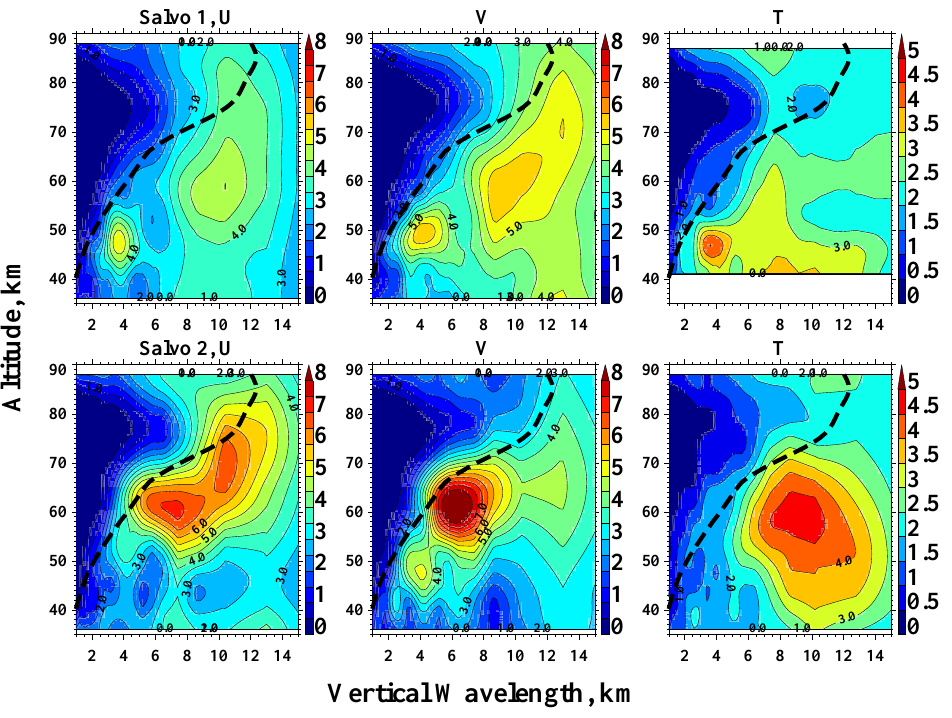
Fig. 6. Salvo mean vertical wavelength-altitude contours of S-transform amplitudes of FS winds and temperature. The dashed lines are the vertical profiles of the Nyquist vertical wavelength corresponding to the FS data. The contour interval is 0.5ms − 1 for winds and 0.5K for